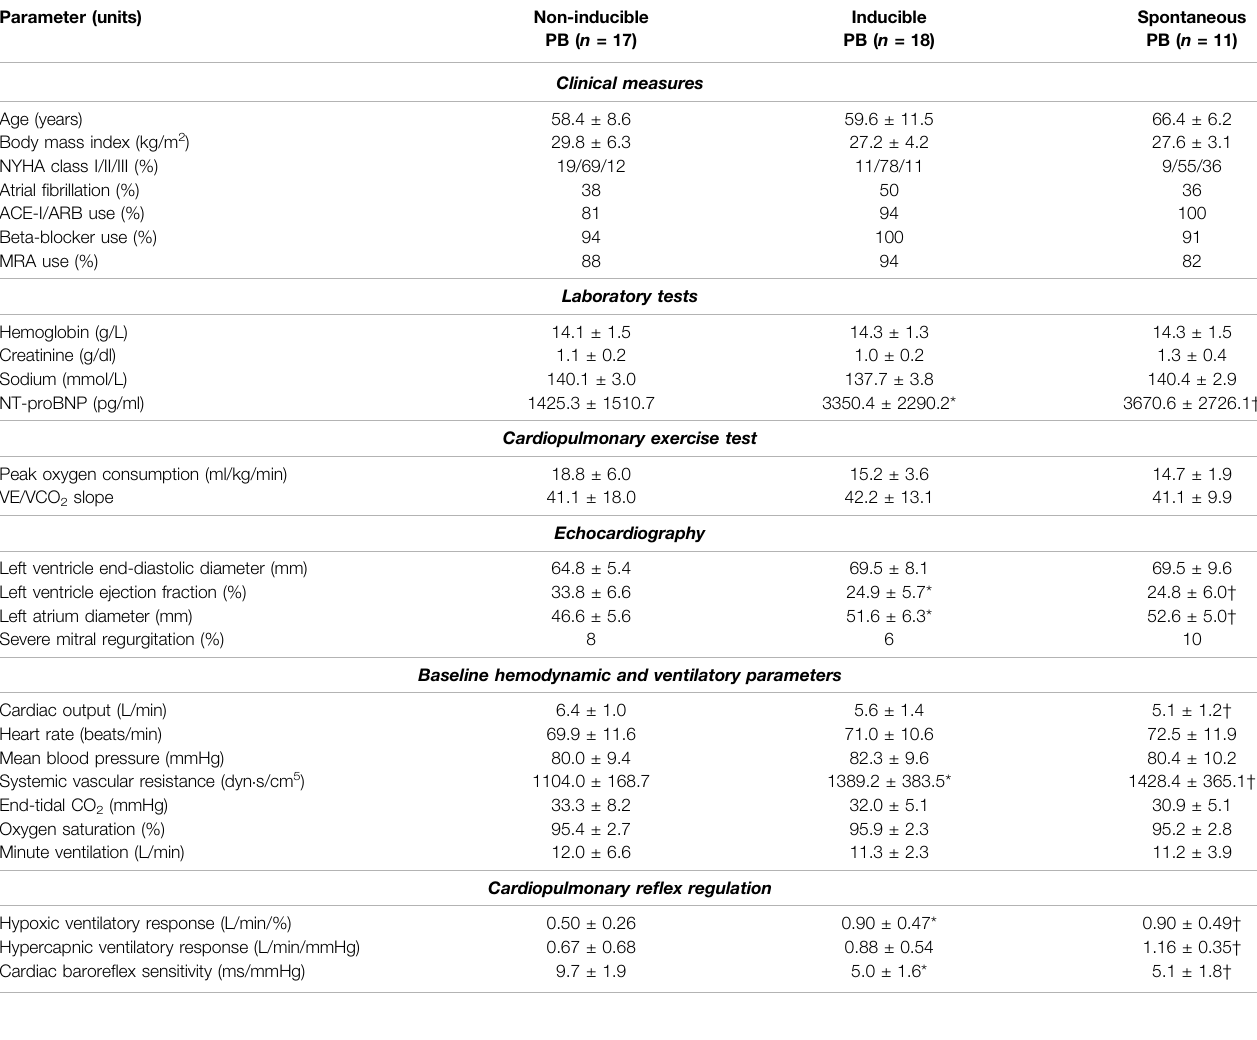
TABLE2| Differencesinmeasuredparametersbetweenstudiedgroups.* p < 0.05forinduciblePB vs. non-induciblePB; † p < 0.05forspontaneousPB vs. non-induciblePB. Parameter (units)